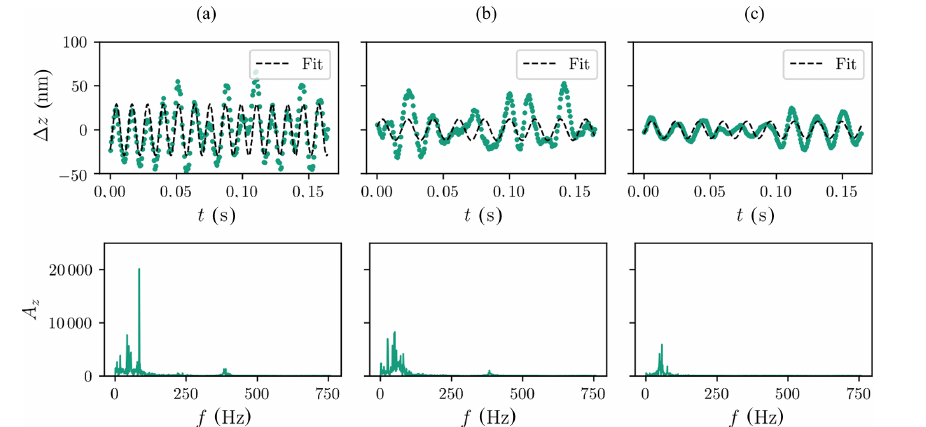
Figure 5. Vibrations in different operational modes: (a) dominant control loop frequency of 90Hz in operational mode, (b) reduced vibrations in emergency stop mode and (c) further reduced vibrations when the machine is turned off. Green lines correspond to the measured values; dashed black lines show the best-fit sinusoidal function.